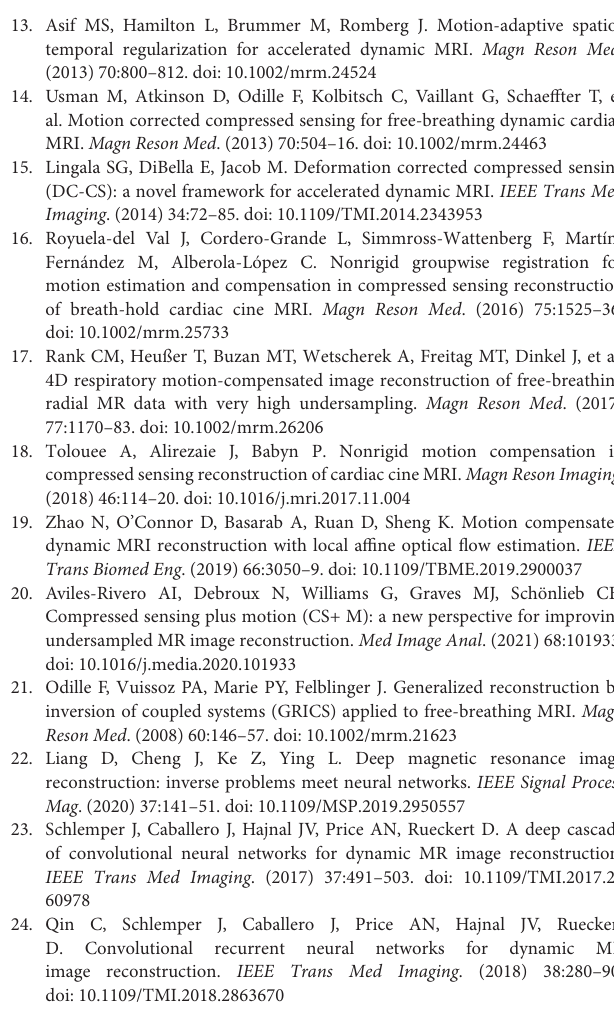
Supplementary Figure S1 | Animated visualization of generated motion fields estimated by PRDRN and GRDRN for a whole dynamic sequence with 8x, 12x and 16x